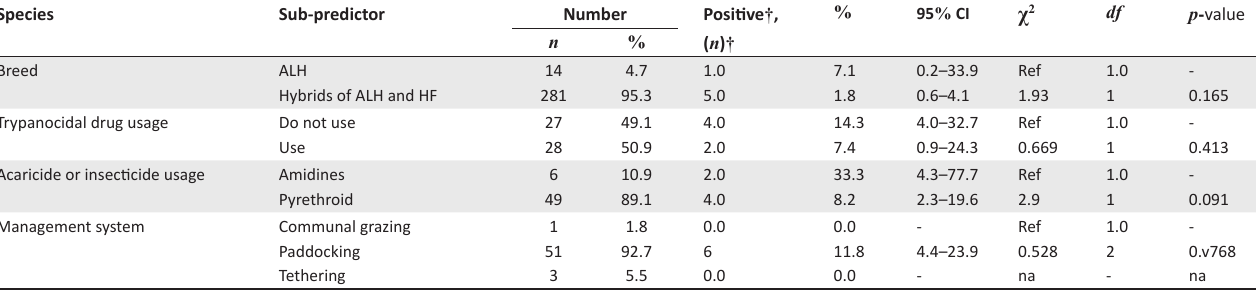
TABLE 1: Predictors of trypanosome infections (295 cattle sampled from 55 farms). Species